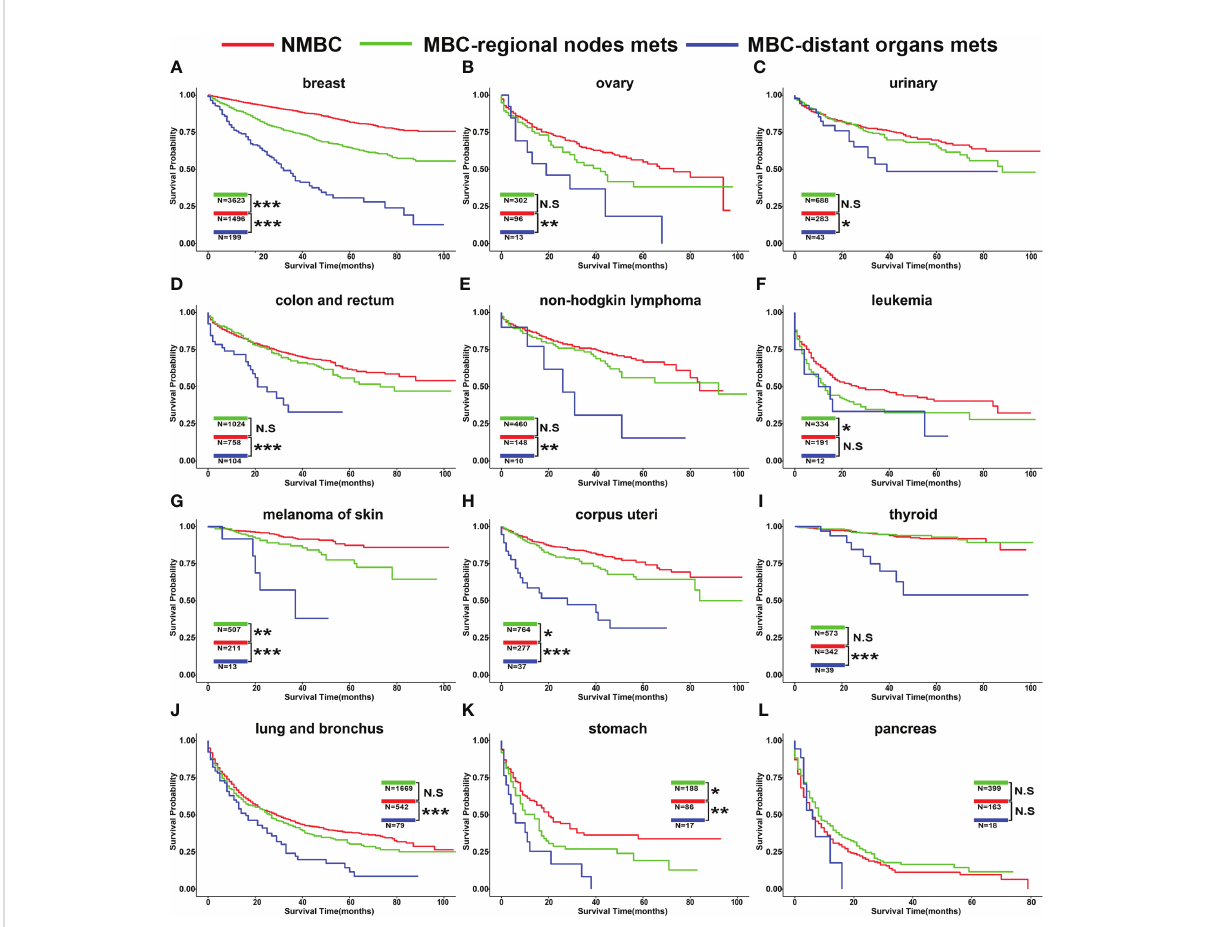
FIGURE 5 The overall survival of SPCs classi fi ed by the metastatic status of breast cancer. Site of SPCs: (A) breast, (B) ovary, (C) urinary, (D) colon and rectum, (E) non-Hodgkin lymphoma, (F) leukemia, (G) melanoma of skin, (H) corpus uteri, (I) thyroid, (J) lung and bronchus, (K) stomach, (L) . pancreas. HR and 95% CIs are shown in Supplementary Table 6.*p < 0.05; **p < 0.01; ***p < 0.001. N.S, not signi fi